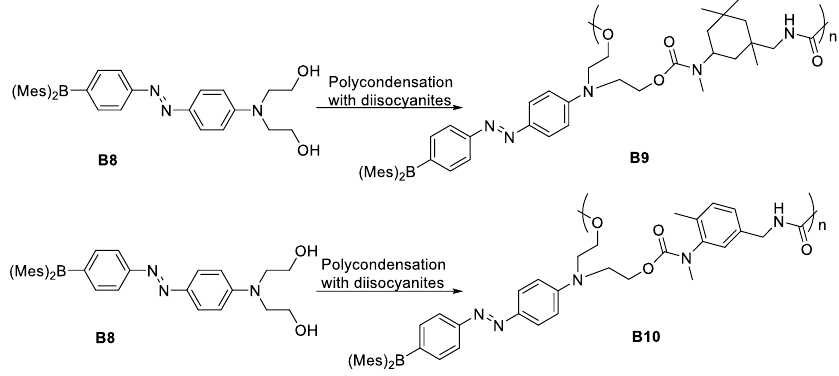
Figure 12. Polyurethanes having azo-dyes with a dimesityl boron group as an electron acceptor.